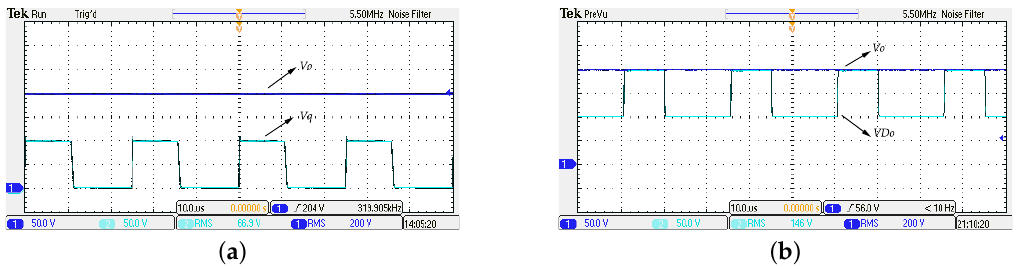
Figure 6. The performance of the proposed converter: ( a ) the voltage wave of the switch ( Q ); ( b ) the voltage wave of the output diode ( D o ).